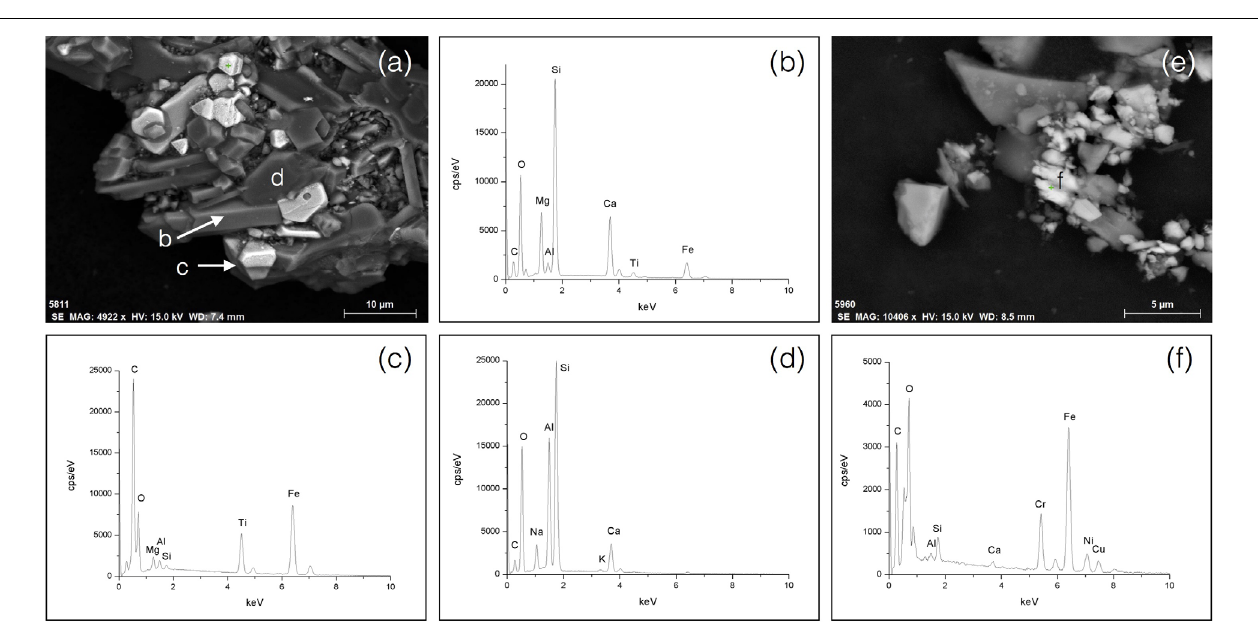
FIGURE 7 | Scanning electron microscopy micrographs and EDS spectra of representative phases of ICE sediments: (a) rock fragment containing augite clinopyroxene (b) , magnetite-ülvospinel (c) and andesine-labradorite plagioclase (d) ; (e,f) Fe-Cr-Ni-bearing hyaloclastic fragments. The green crosses mark the spot